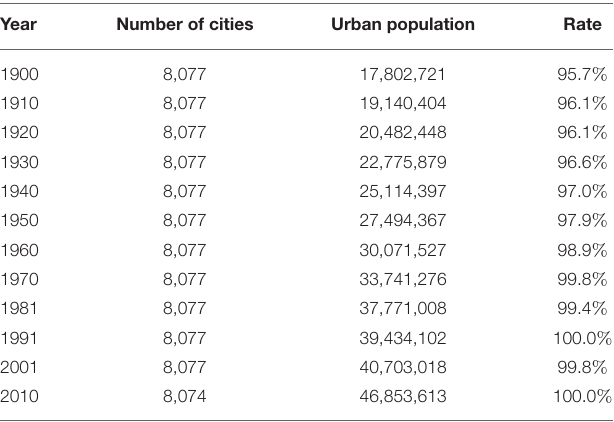
TABLE 3 | Summary of population data for Spain.